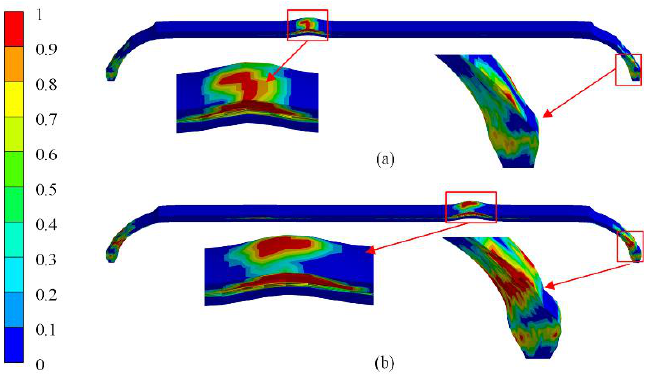
Figure 21. Comparison of numerical result of the fiber damage at the burst pressure: ( a ) present method, ( b ) the cubic spline function method.